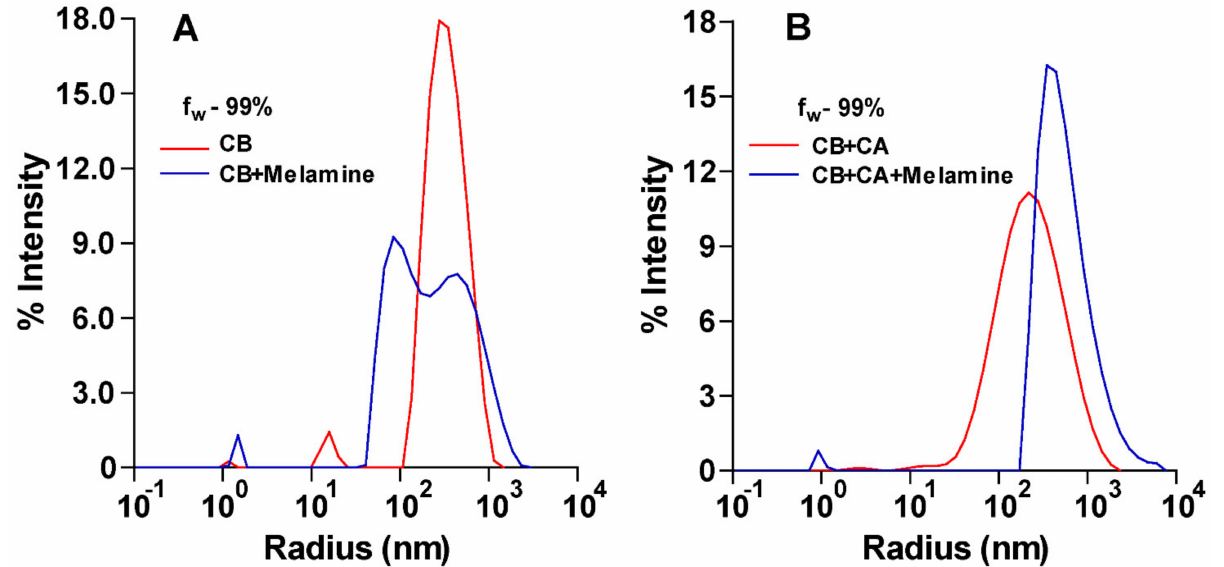
Figure 4. DLS measurements of ( A ) CB solution (10 µ M) in the absence and presence of melamine (1000 µ M); a shift of aggregate size distribution to smaller sizes was observed upon addition of melamine. ( B ) CB-CA solution in the absence and in the presence of melamine (100 ppm); a shift of aggregate size distribution to larger sizes was observed upon addition of